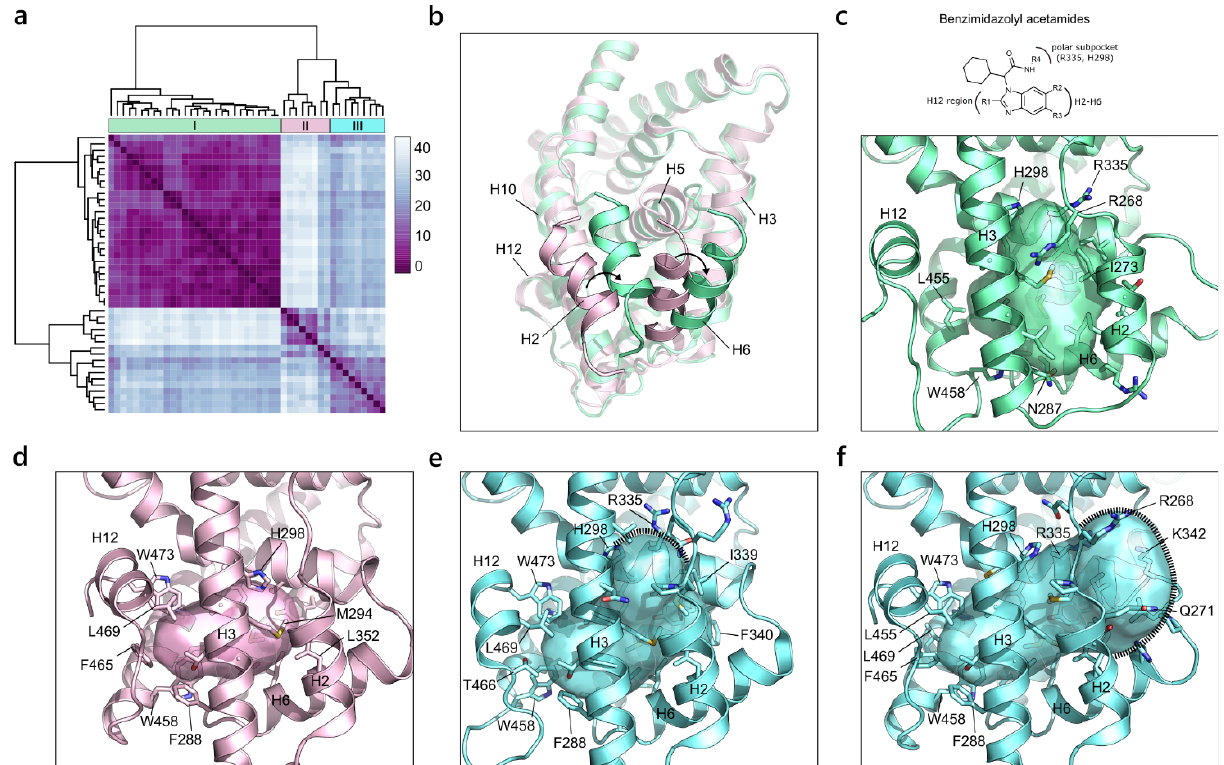
Figure 8. ( a ) Heatmap of the hierarchical clustering of FXR. ( b ) Superposition of FXR structures containing H2 and H6 in the canonical (pink, PDB ID 5ICK) and non-canonical (green, PDB ID 5Q1H) conformations. ( c ) Representation of the pocket defined by cluster I (PDB ID 5Q1H) as a result of the binding of compounds that contain a benzimidazolyl acetamide scaffold (reported on the top). ( d ) Depiction of the pocket illustrated by cluster II (PDB ID 5ICK). ( e , f ) Representation of the two expanded pockets described by cluster III (PDB IDs 5Q0W and 6A5Y,